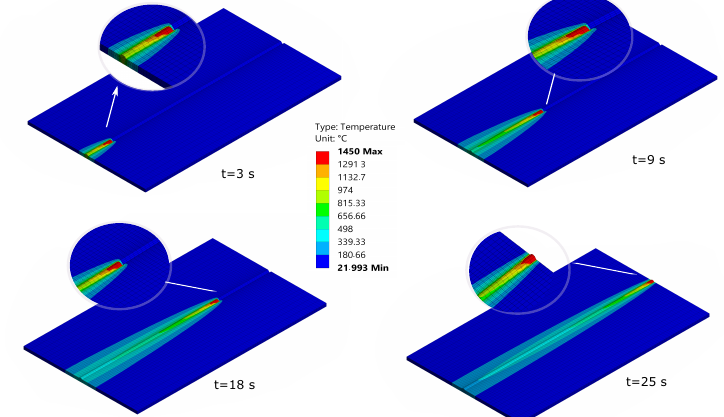
Figure 3. Element birth process in the thermal analysis of a welding process of the IN718 material